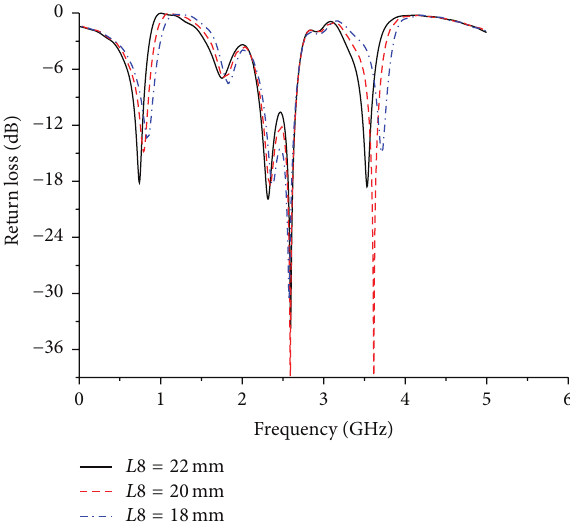
Figure 5: Simulated return loss characteristics for the proposed antenna for various values of 𝐿8 .